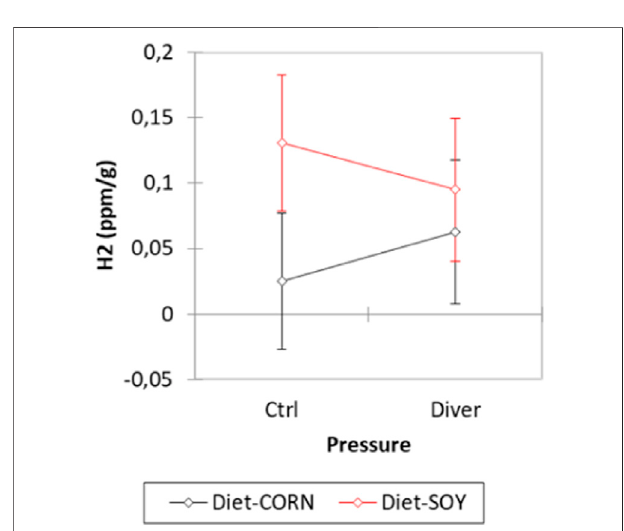
FIGURE 4 | Exhaled hydrogen analysis before the dive from Control and Diver rats, according to their diet (MAIZE or SOY).